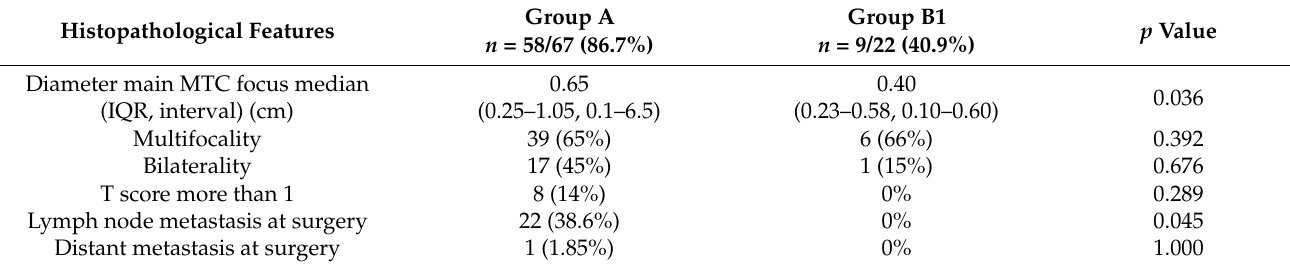
Table 2. Histopathological features of MTCs of Group A and B1